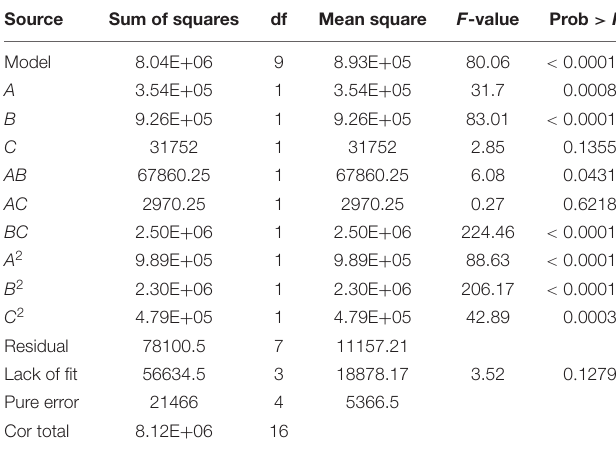
TABLE 2 | Analysis of variance for the results of BBD.